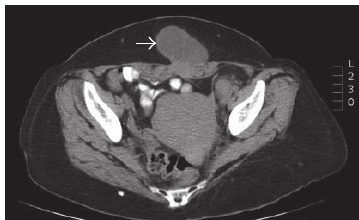
Figure 1: Abdomen and pelvis computed tomography (CT) scan revealed a 6.0-centimeter mass (arrow) involving linea alba, bilateral rectus abdominis, and subcutaneous fat. The mass was not attached to any organs. Also noted was prominent left external iliac and inguinal lymphadenopathy.